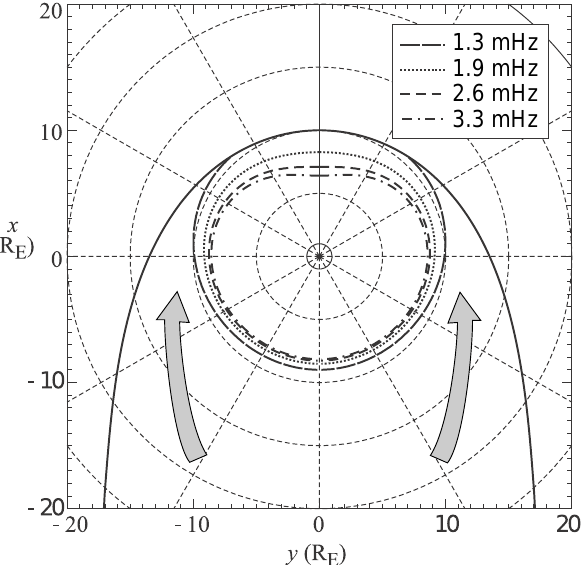
Figure 13. Magnetospheric equatorial plane showing turning points for fast wave at several frequencies. The large grey arrows indicate the direction of a fast wave propagated from the tail into the waveg- uide. (Adapted from Walker,